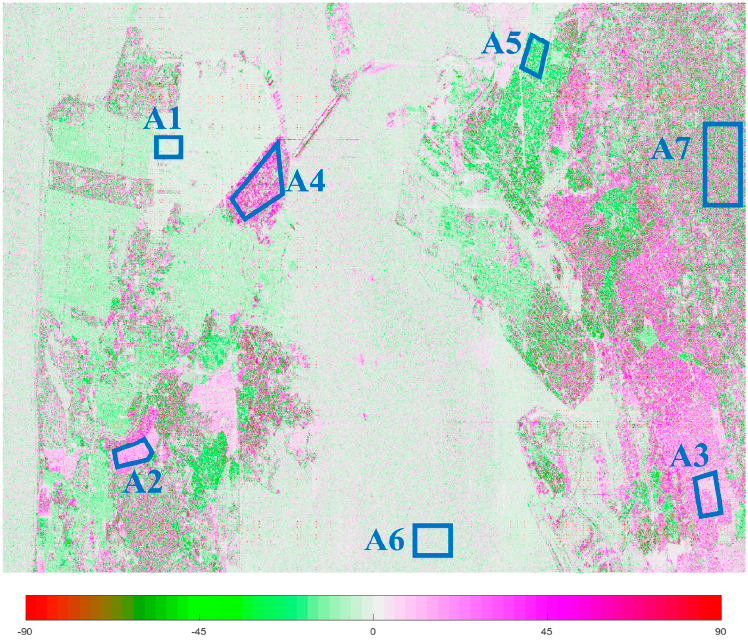
Figure 8. Orientation angle estimation of ALOS-2/PALSAR-2 data sets.